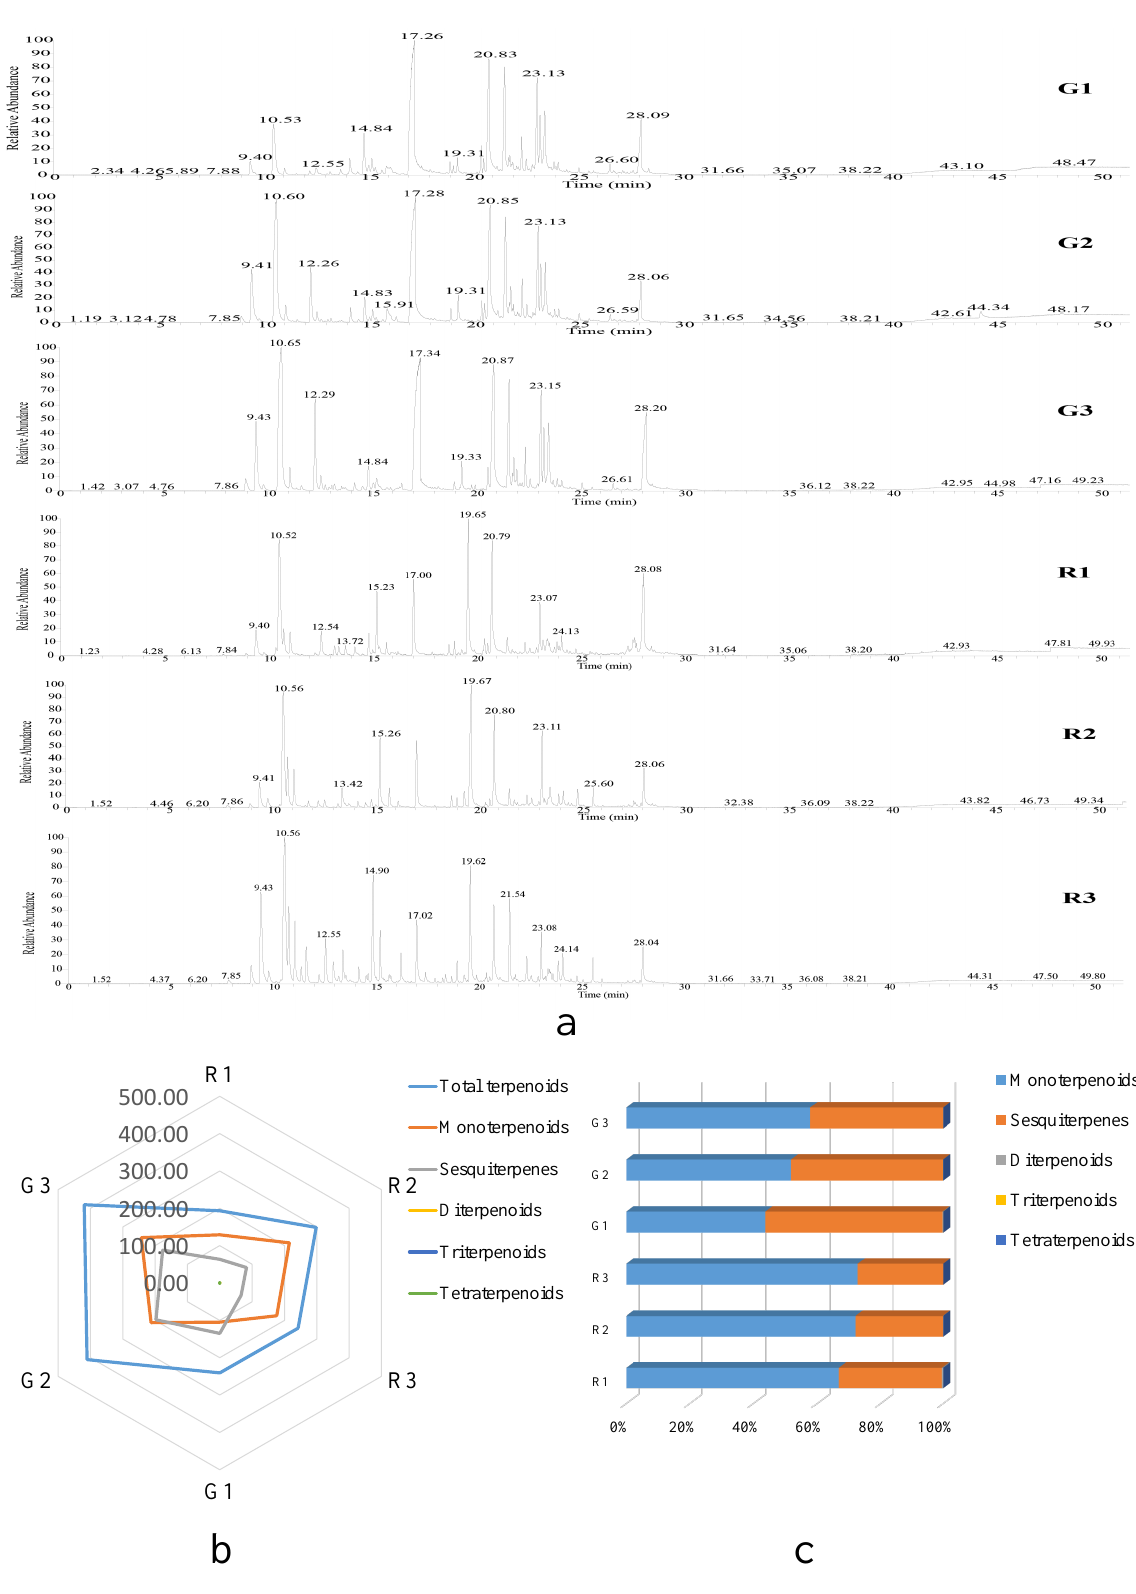
Figure 2. GC-MS analysis of terpenoids in green and red prickly ash fruits. ( a ) GC-MS chromatograms of different developmental stages of green and red prickly ash fruit. ( b ) Radar chart of the contents of different terpenoid classes in green and red prickly ash fruits at three developmental stages (mg/100 g). ( c ) Percentage of different terpenoid classes in green and red prickly ash fruit at different developmental